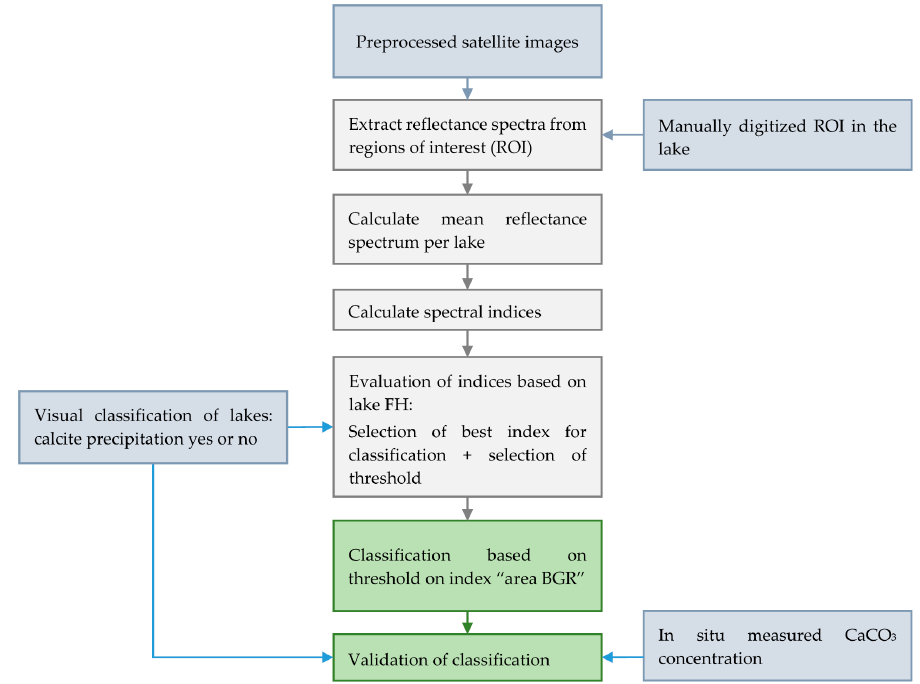
Figure 6. Flowchart of the processing steps of Landsat surface reflectance data for the monitoring of calcite precipitation. The blue boxes contain input data, the gray boxes illustrate the development of the robust classification and the orange boxes illustrate the classification and validation.